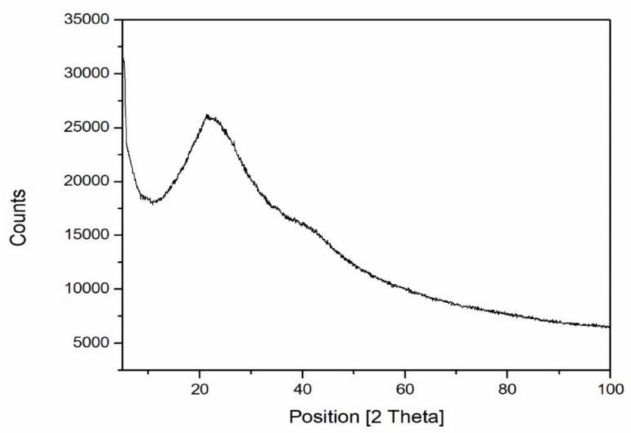
Figure 5. X-ray di ff raction (XRD) spectrum of the synthesized copper nanoparticles.